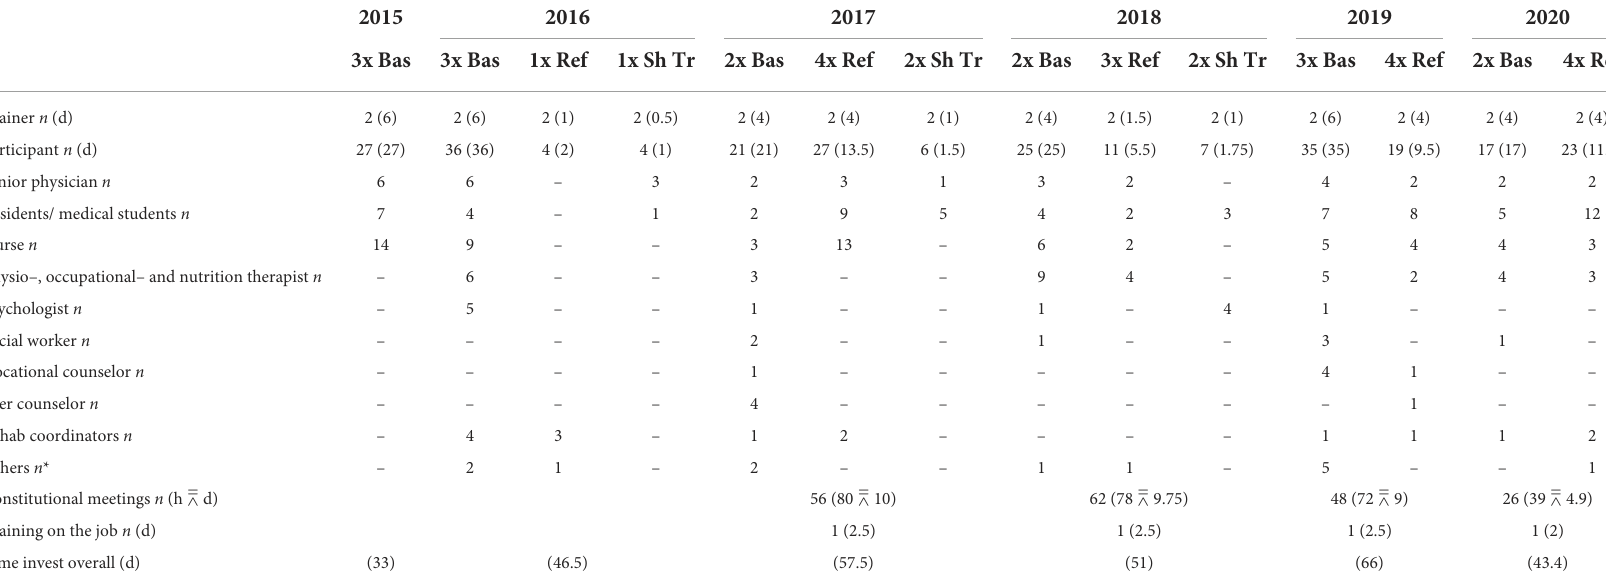
TABLE 2 Time invested for education in different